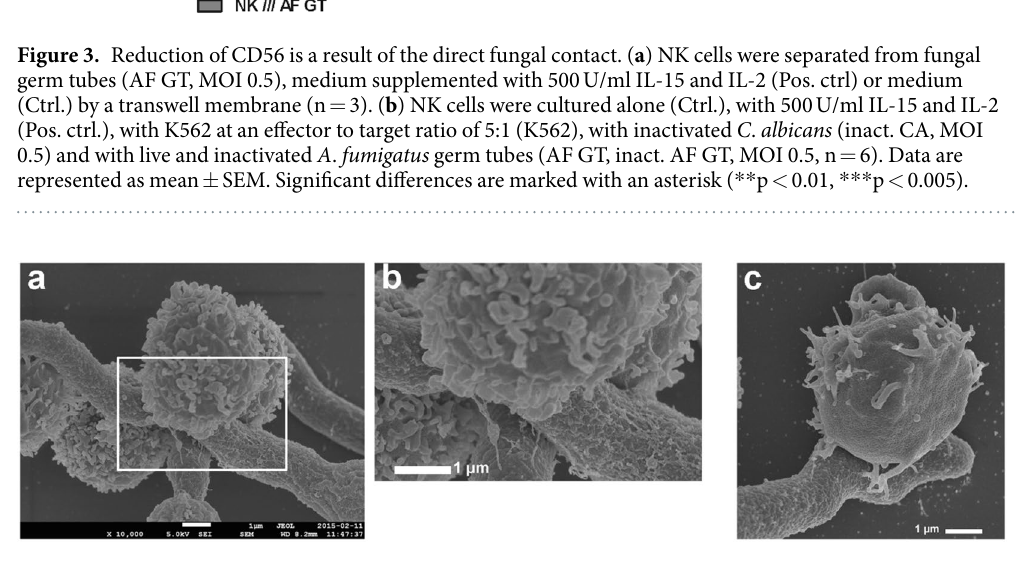
Figure 4. Direct contact with A. fumigatus hyphae. NK cells- A . fumigatus 3 h co-culture specimens were inspected with a field emission SEM using a detector for secondary electrons at 5 kV and a magnification of × 10,000. Representative result of two independent experiments performed in duplicates. Picture ( b ) is a zoom in of ( a ), illustrating the interaction site of NK cells with A . fumigatus hyphae. Scale bar for ( a – c ): 1 µ